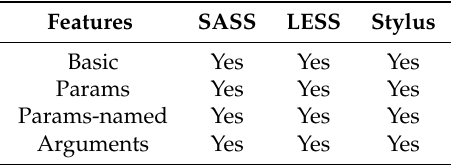
Table 4. Mixins’ features